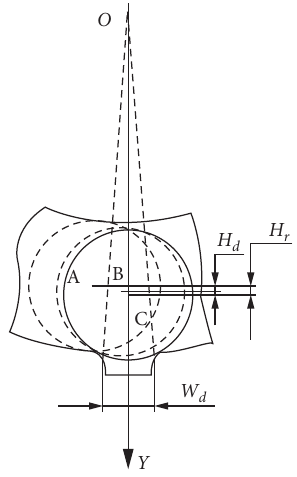
Figure 5: Time-varying displacement caused by defect.